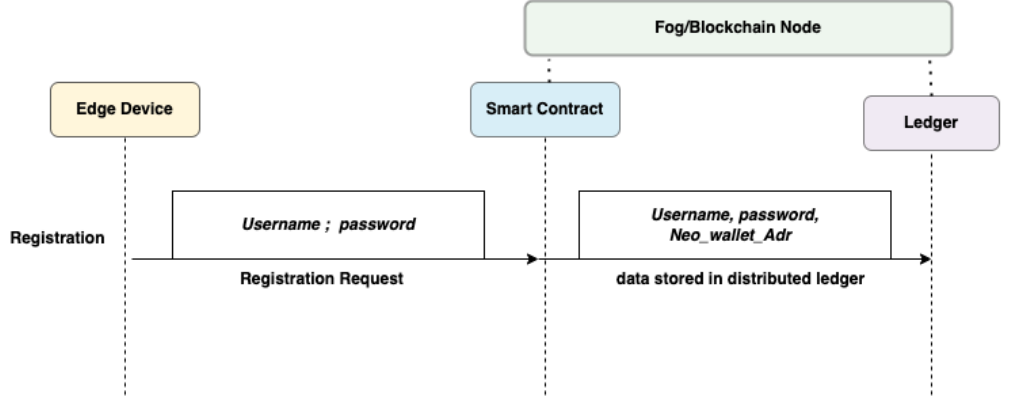
Figure 3. Flow diagram for User